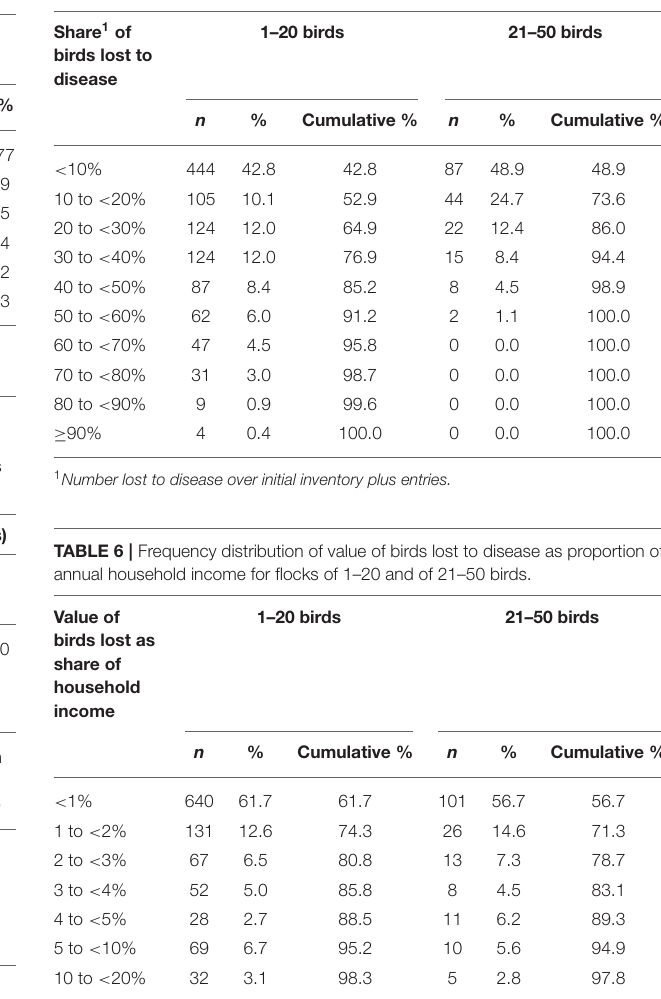
TABLE 3 | Distribution of share (%) of household income from livestock/poultry of rural poultry-keeping households (hhs) in Tanzania in 2012/2013. All poultry keeping Poultry only livestock